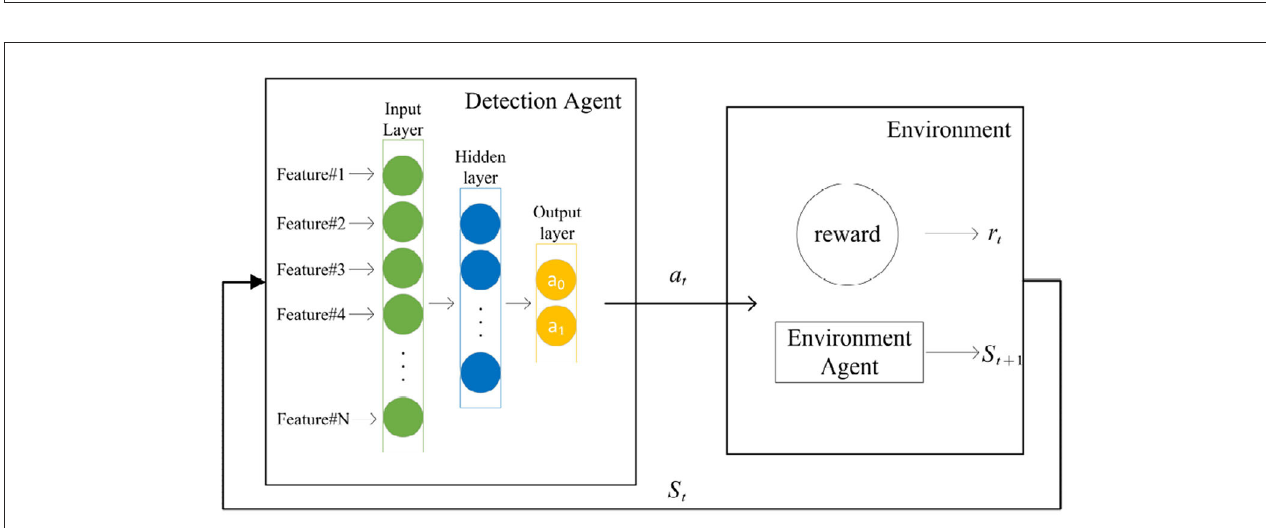
FIGURE3 The structure of fault detection, including the detection agent and environment